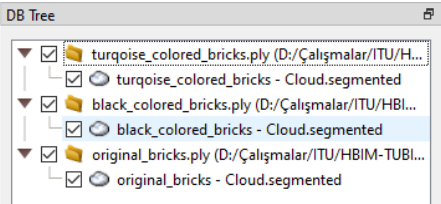
Figure 9. Segmented points in Cloud Compare DB Tree. Three unique points cloud data of different coloured bricks are named separately according to their specifications. Naming was also an essential step for training inputs and outputs because we aimed for differentiated brick units at the end of the research.